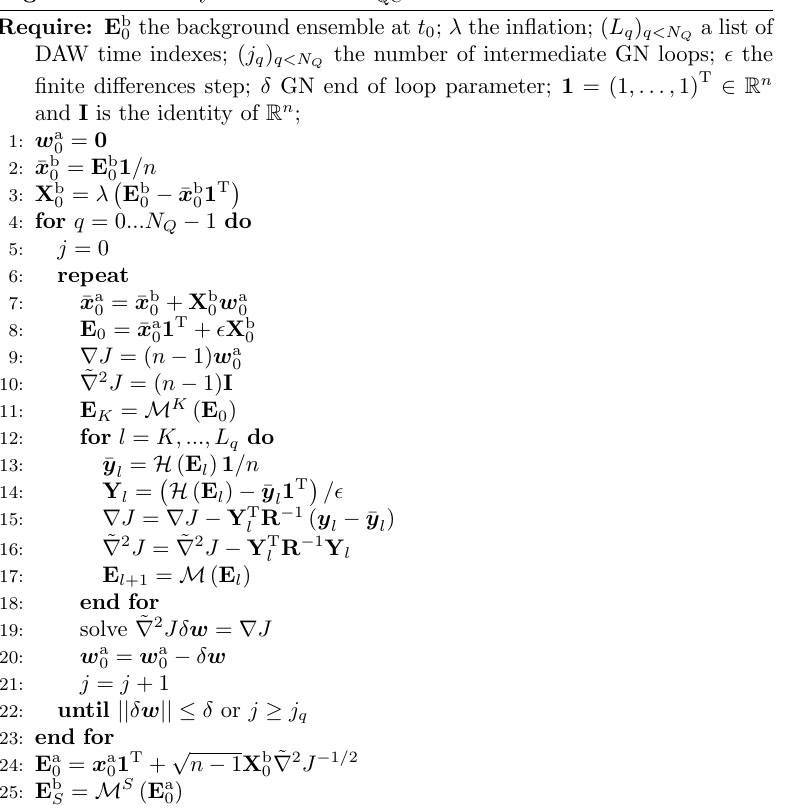
Algorithm 2 One cycle of the IEnKS